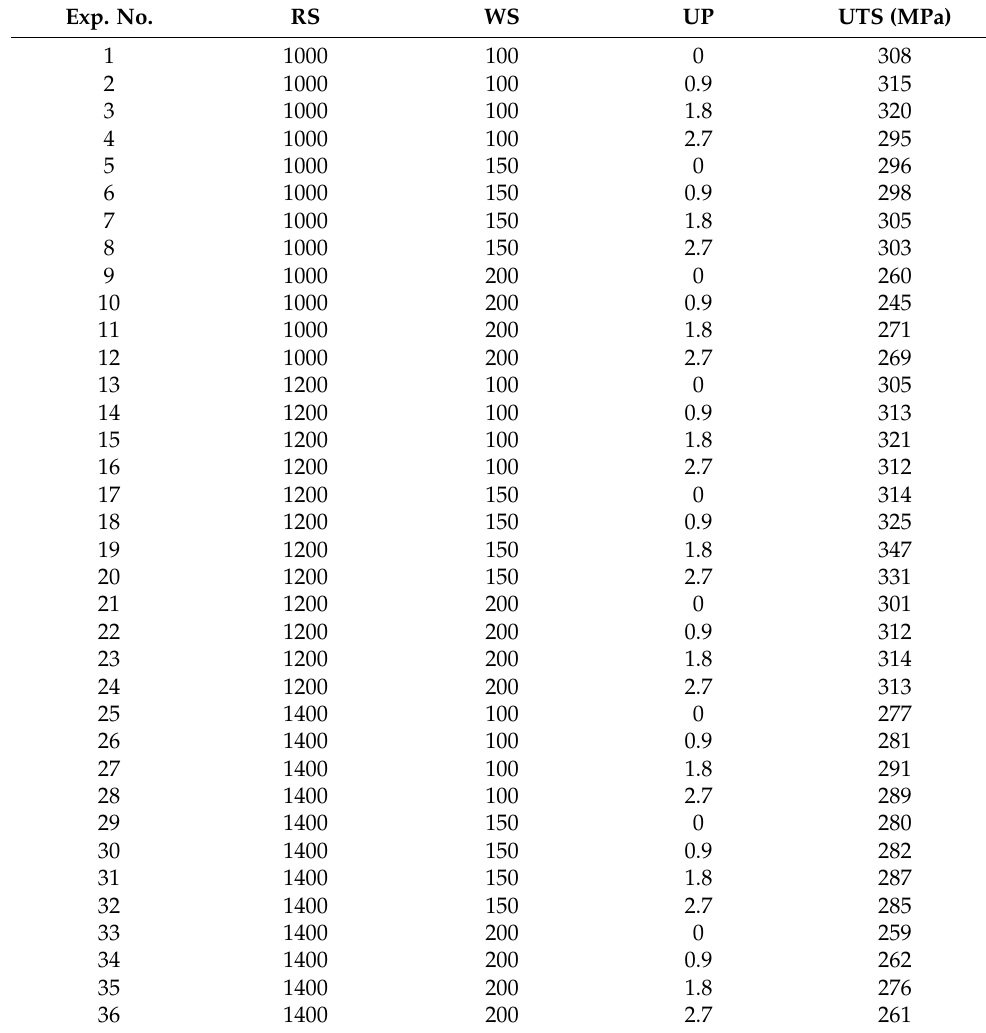
Table 4. Design of experiment and corresponding response